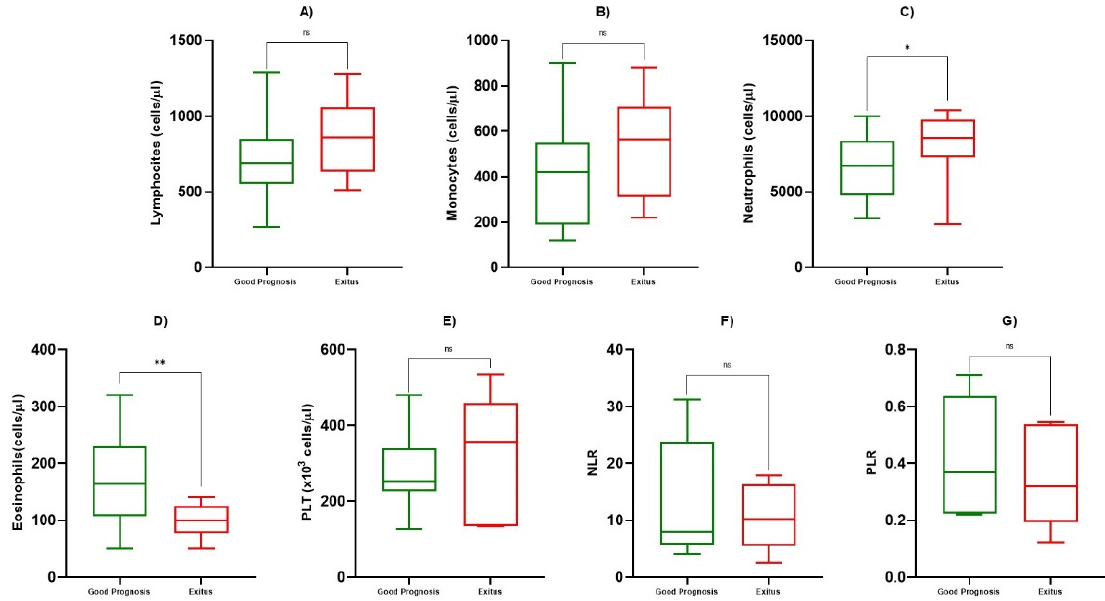
Figure 1. Box and whiskers of blood value. Box and whiskers among good prognosis and exitus patients at first determination for ALC in ( A ), for AMC in ( B ), for ANC in ( C ), for AEC in ( D ), for PLT in ( E ), for NLR in ( F ), and for PLR in ( G ). The significant p -values are marked with * (from 0.01 to 0.05) or ** (from 0.001 to 0.01), not significant are marked with ns ( ≥ 0.05).